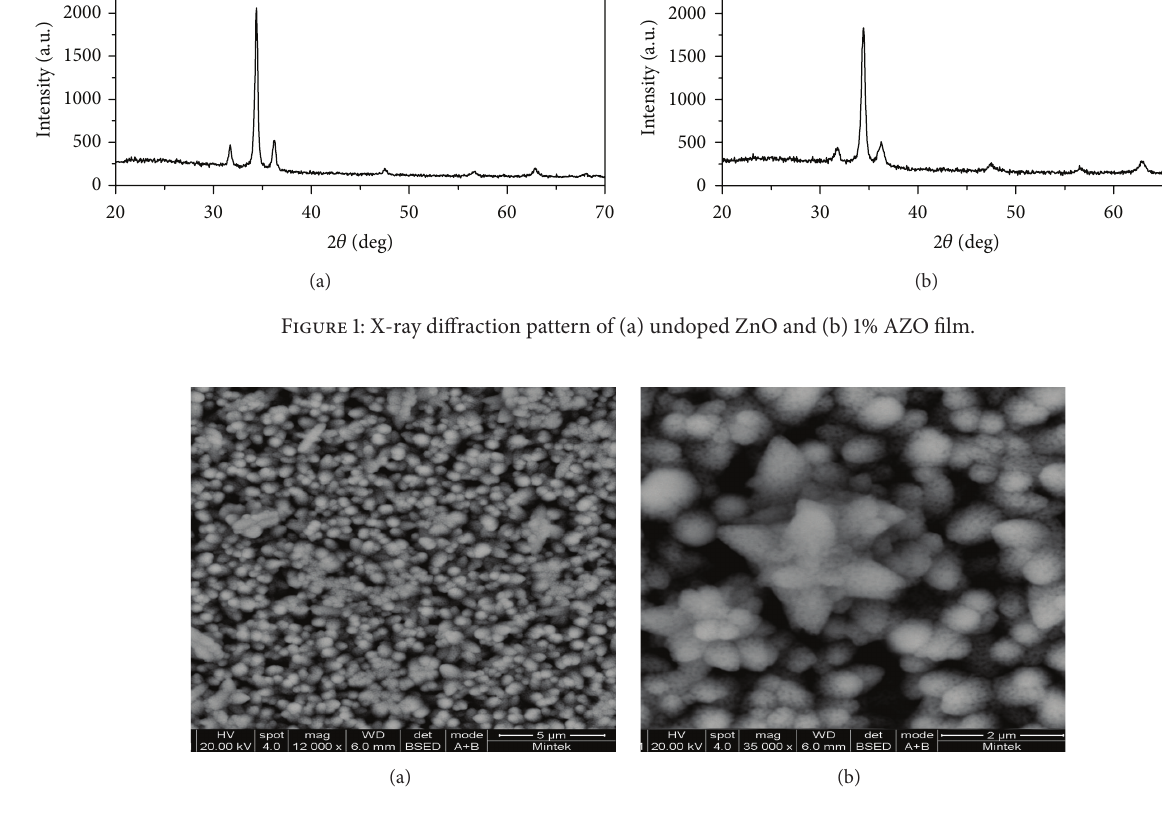
Figure 2: SEM image of undoped ZnO (a) with magnification × 12000 and (b) with magnification ×